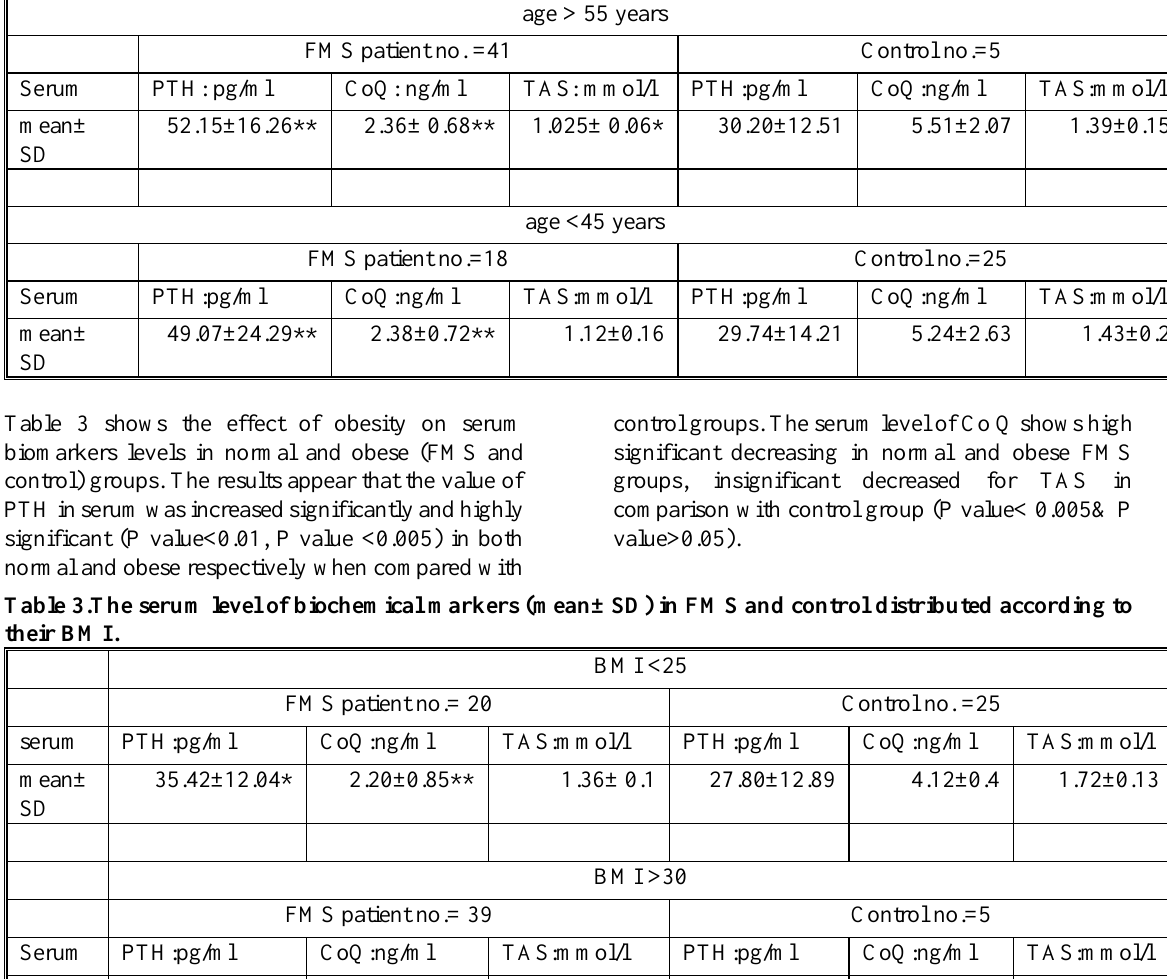
Table 2. The serum level of biochemical markers in both FMS patients and control distributed according to their ages represented by (mean± SD).